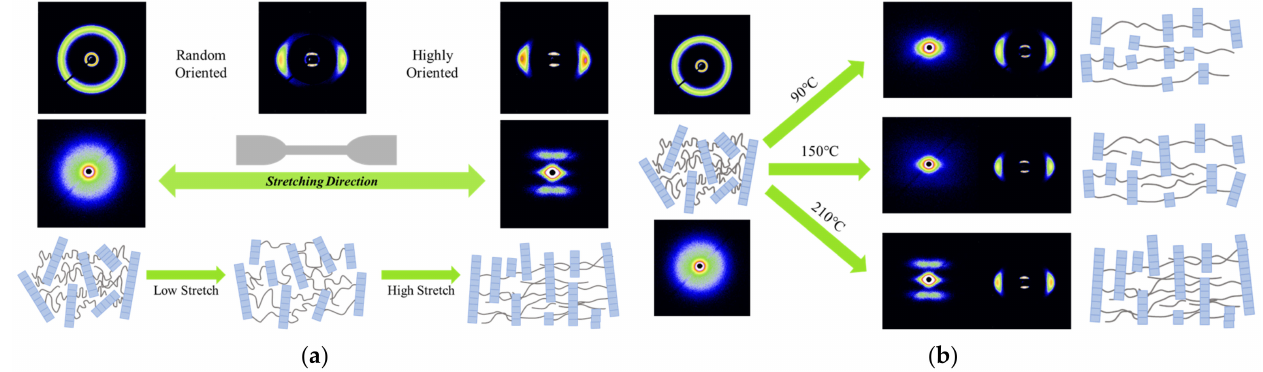
Figure 9. Schematic model of structure evolution during uniaxial stretching at ( a ) different stretching ratios; ( b ) different stretching temperatures.